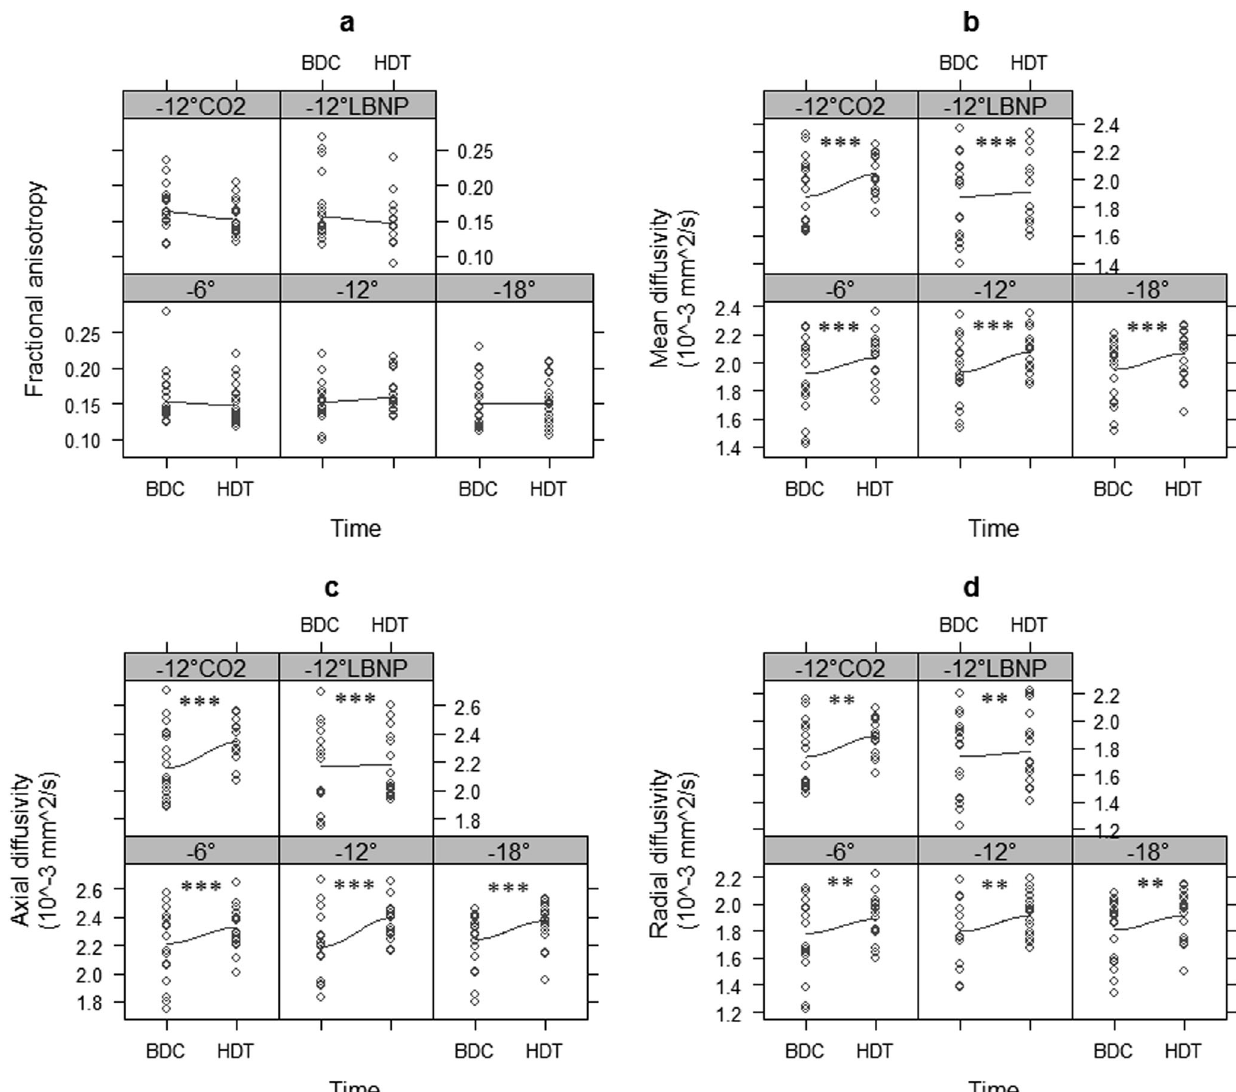
Fig. 3 ON sheath diffusion parameters including FA a , MD b , axial diffusivity (AD) c and radial diffusivity (RD) d for all conditions ( − 6°, − 12°, − 18°, − 12°, and CO2, − 12° and LBNP) compared with the corresponding baseline value. Asterisks indicate signi fi cance level from linear mixed effects (LME) corresponding to time effect: *( P = 0.05), **( P < 0.01), ***( P <